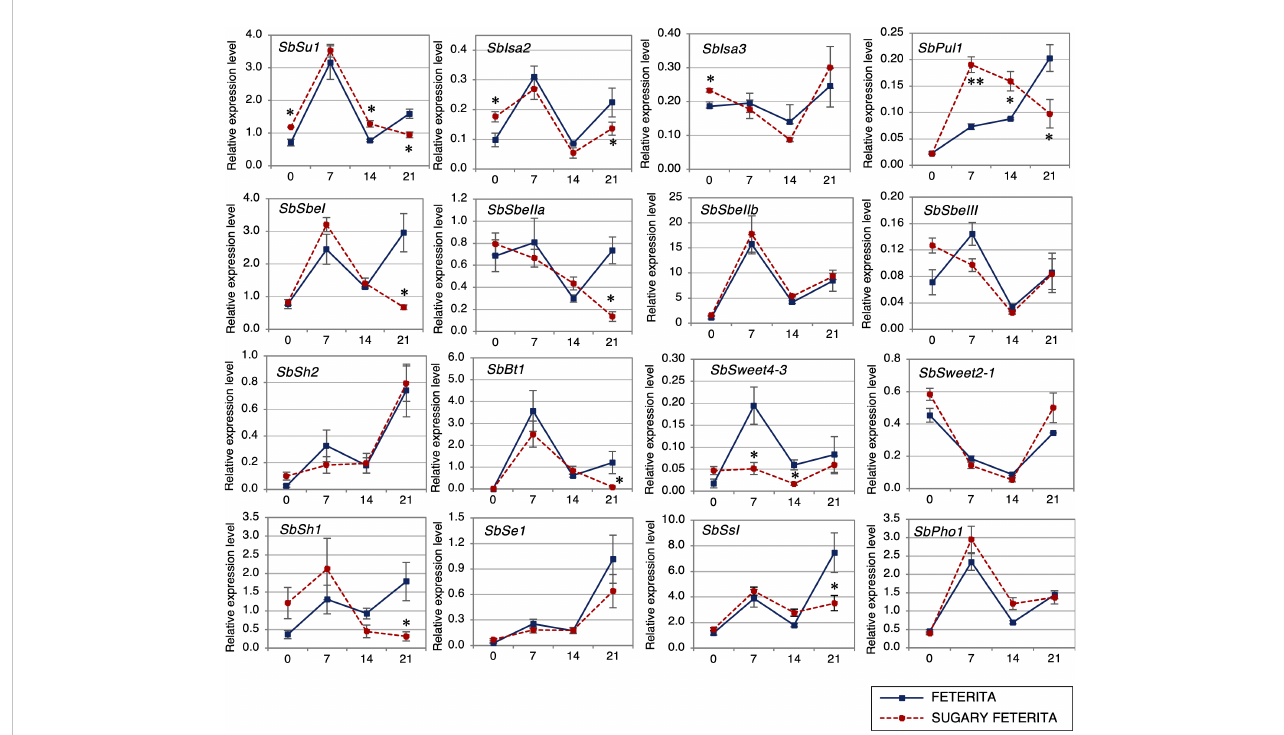
FIGURE 4 Expression pro fi les of starch synthesis genes of sorghum during seed development in wild-type ‘ FETERITA ’ and ‘ SUGARY FETERITA ’ . Total RNA was extracted from seeds at 0, 7, 14, and 21 days after fl owering (DAF), and qRT-PCR was conducted for 16 genes; SbSu (Sobic.007G204600), SbIsa2 (Sobic.009G127500), SbIsa3 (Sobic.002G233600), SbPul1 (Sobic.006G015800), SbSbe1 (Sobic.010G273800), SbSbeIIa (Sobic.006G066800), SbSbeIIb (Sobic.004G163700), SbSbeIII (Sobic.003G213800), SbSh2 (Sobic.003G230500), SbBt1 (Sobic.004G085100), SbSweet4-3 (Sobic.004G133600), SbSweet2-1 (Sobic.001G377600), SbSh1 (Sobic.010G072300), SbSe1 (Sobic.005G199300), SbSsI (Sobic.010G047700), SbPhoI (Sobic.001G083900). Expression levels are shown relative to the expression of the sorghum ubiquitin ( SbUbi ; Sobic.001G311100) gene. All data are shown as means ± SE from three biological replicates. Two-tailed unpaired t-tests were used to determine signi fi cant differences. *P < 0.05 and **P < 0.01. More detail about each target gene can be found in Supplementary Figure